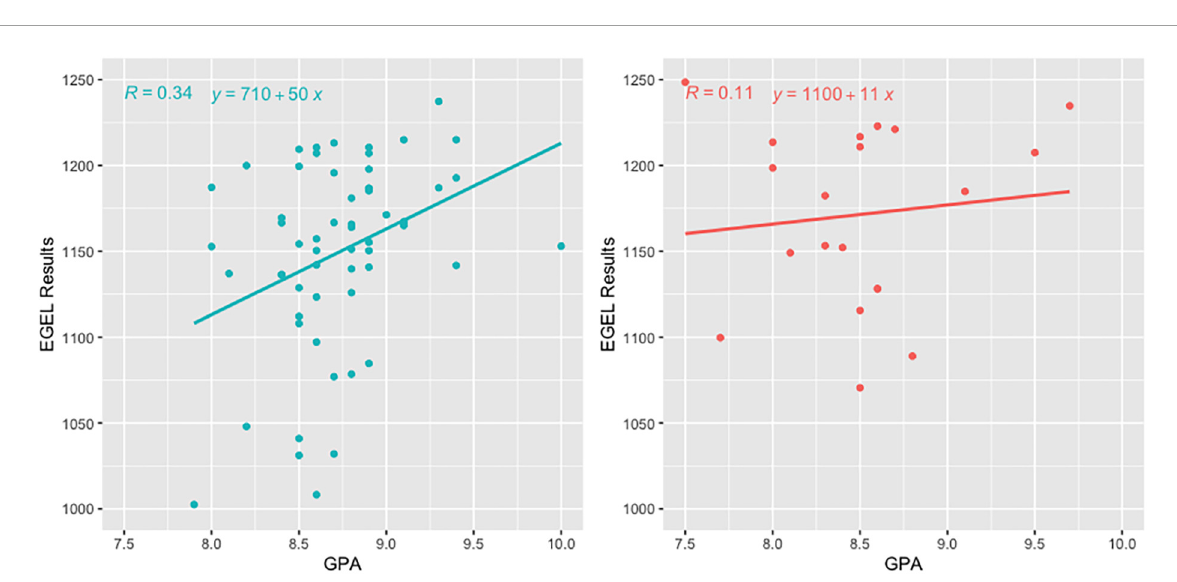
for Food Process Design with an R = 0.26, the higher their self-evaluation, the higher their IDIORPROA EGEL